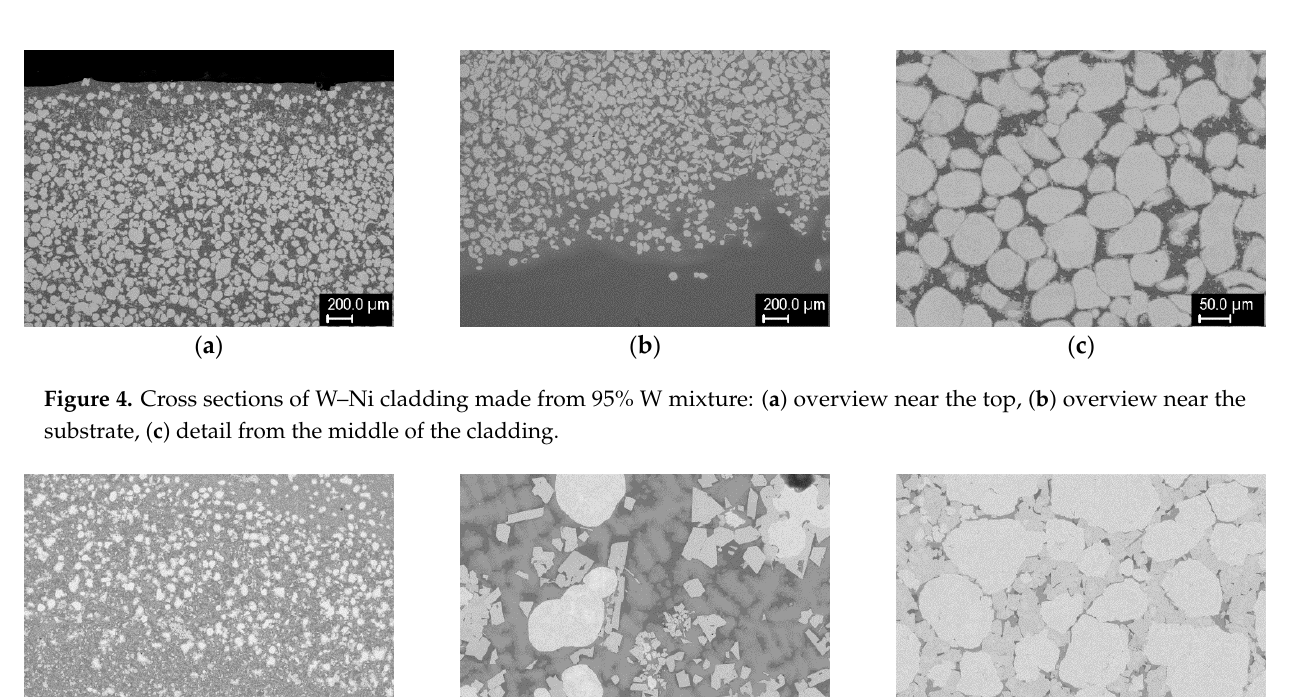
Figure 4. Cross sections of W–Ni cladding made from 95% W mixture: ( a ) overview near the top, ( b ) overview near the substrate, ( c ) detail from the middle of the cladding.